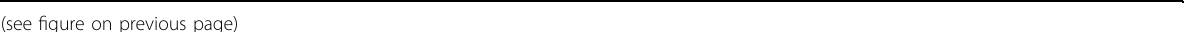
(see fi gure on previous page) Fig. 1 Dynamic changes in autophagy in an animal model of SAKI. A Pathological observation of the kidney cortex after H&E staining (upper panel) and PAS staining (lower panel). The irregular brush border (arrow) and ectasia of affected tubules (arrowheads) were observed following CLP surgery (upper panel: 200×; inset: 400×; scale bar = 10 μ m). B The tubular damage score was evaluated based on pathological observation ( n = 10). C Apoptosis was semi-quantitatively analysed by TUNEL-positive cell staining (upper panel: 200×; lower panel: 400×; scale bar = 5 μ m). D The number of TUNEL-positive cells ( n = 10). E Morphological observation of autophagy in the kidney cortex under an electron microscope (black arrow: autophagosomes; Mito: mitochondrion; upper panel: magni fi ed ×8000 and scale bar = 2 μ m; lower panel: magni fi ed ×20000 and scale bar = 1 μ m). F The number of autophagosomes in renal epithelial cells was calculated in 20 randomly selected fi elds ( n = 20). G – J Representative western blot with densitometric analysis of Beclin1, LC3 II and SQSTM1 protein expression ( n = 6). The data are presented as the mean ± SD. * p < 0.05, ** p < 0.01 and *** p < 0.001 vs the 0-h group. SAKI sepsis-induced acute kidney injury, CLP caecal ligation and puncture, PAS periodic acid – Schiff staining, H&E haematoxylin – eosin staining, TUNEL terminal deoxynucleotidyl transferase dUTP nick end labelling staining, GAPDH glyceraldehyde 3-phosphate